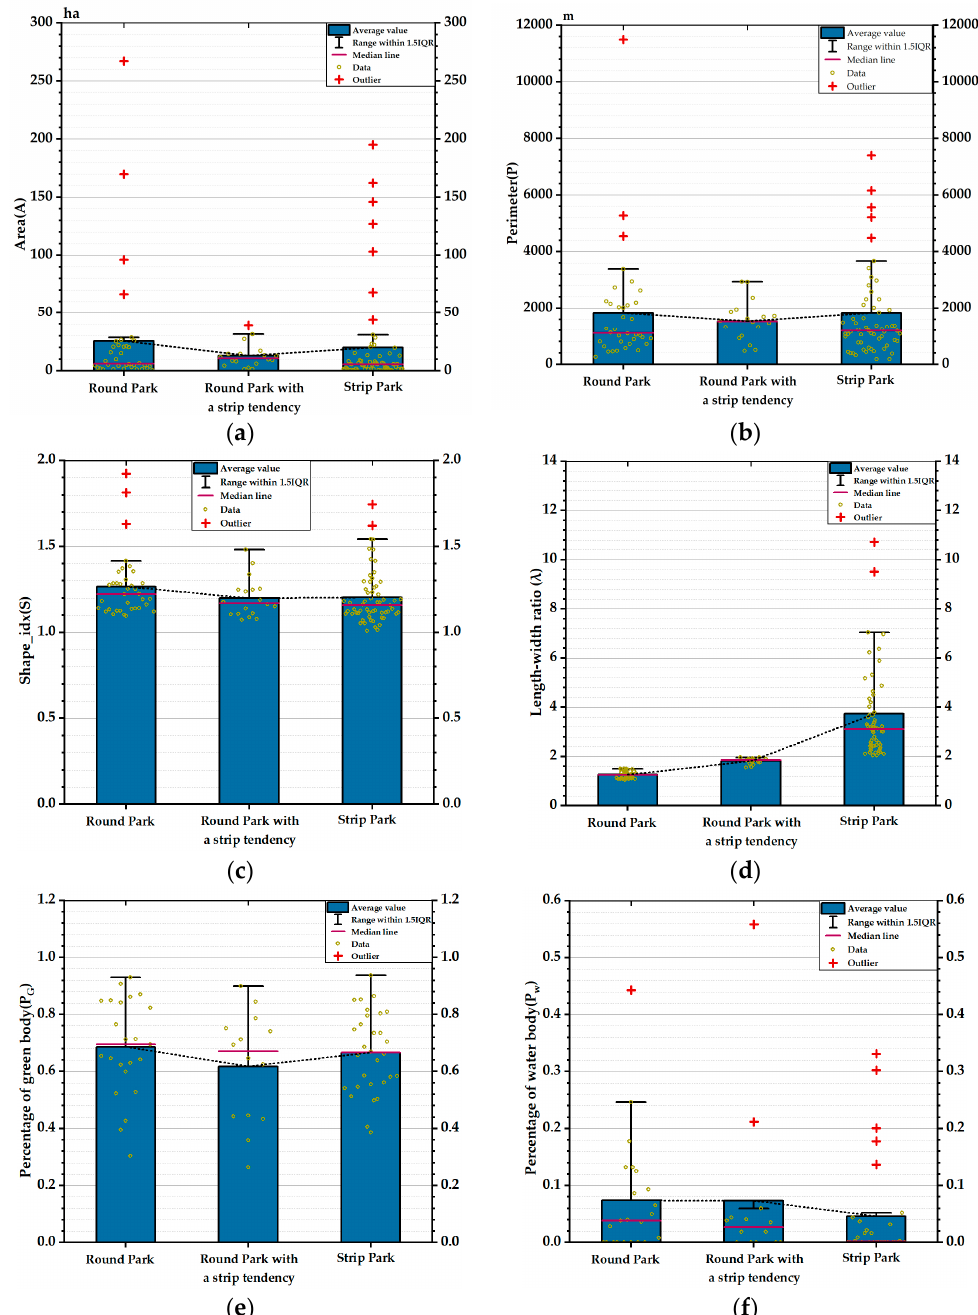
Figure 4. Morphological indexes of the 117 urban parks: ( a ) area; ( b ) perimeter; ( c ) minimum length–width ratio of an external rectangle; ( d ) shape index; ( e ) percentage of water body; ( f ) percentage of green body.